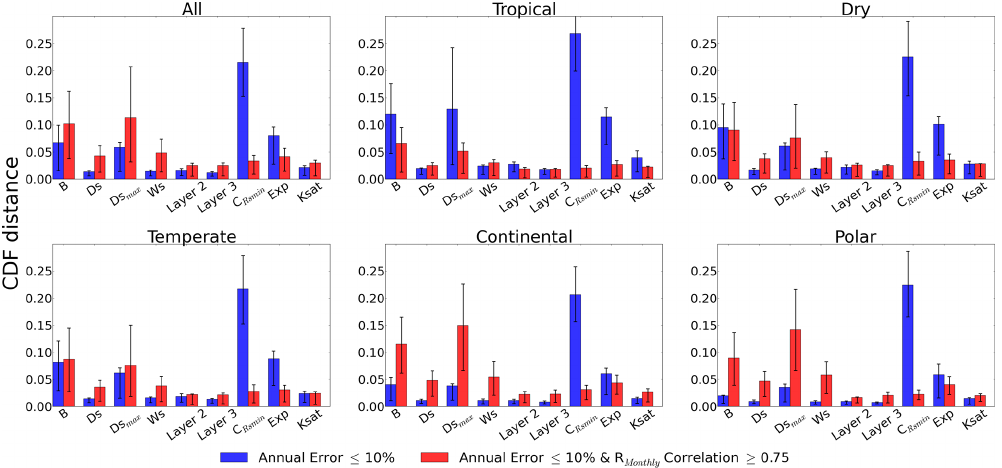
Figure 5. Climate average sensitivity of each VIC parameter used in the 10000 Latin hypercube sample simulations. The CDF distance is calculated for each VIC parameter after applying the annual error constraint and again after applying the monthly correlation constraint. The error bars quantify the variability within the climate type (25th and 75th